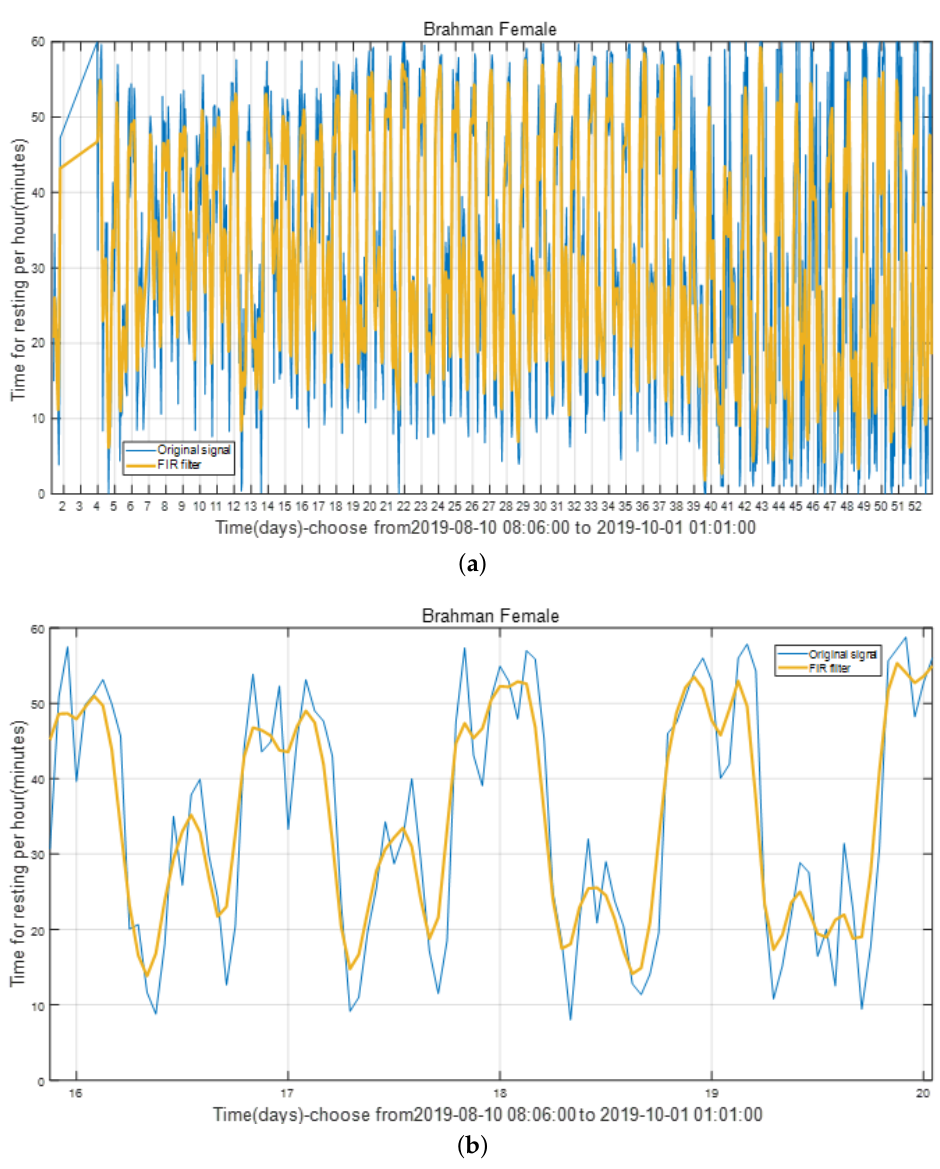
Figure 8. The resting time of cattle during the whole period after using the FIR filter. ( a ) The whole sample period. ( b ) The enlarge vision shown 4